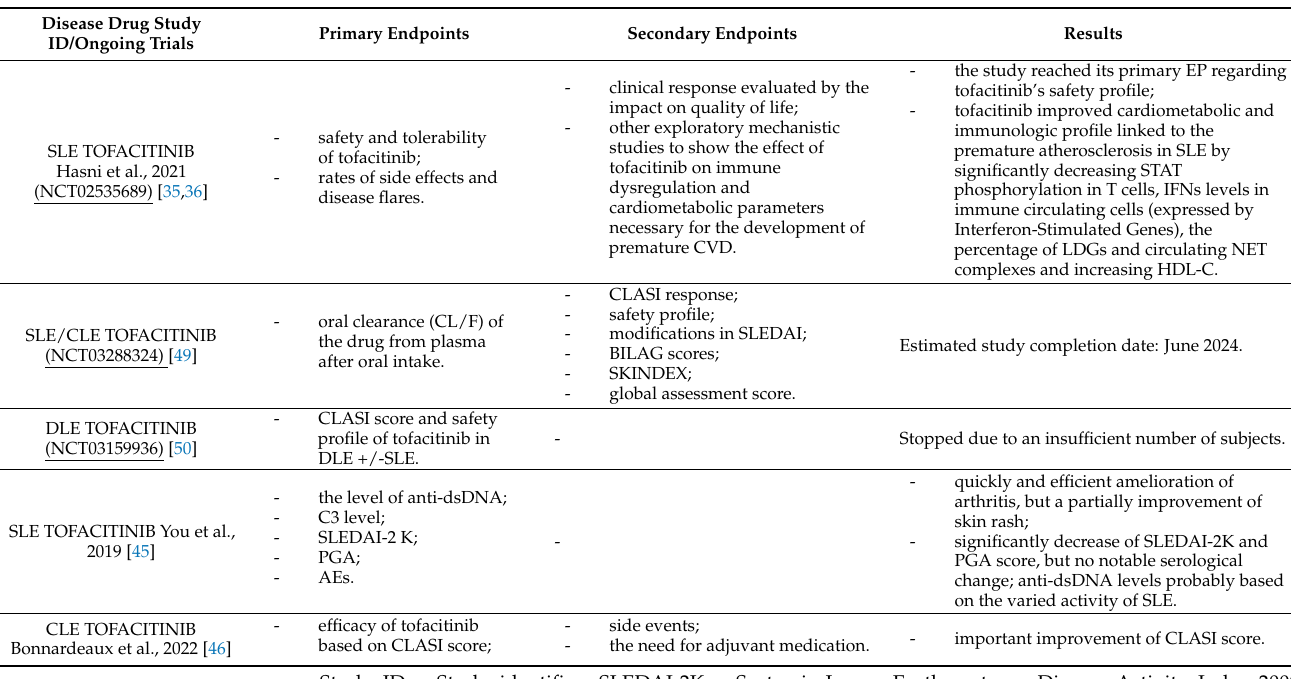
Table 2. Tofacitinib-main results of clinical trials in SLE